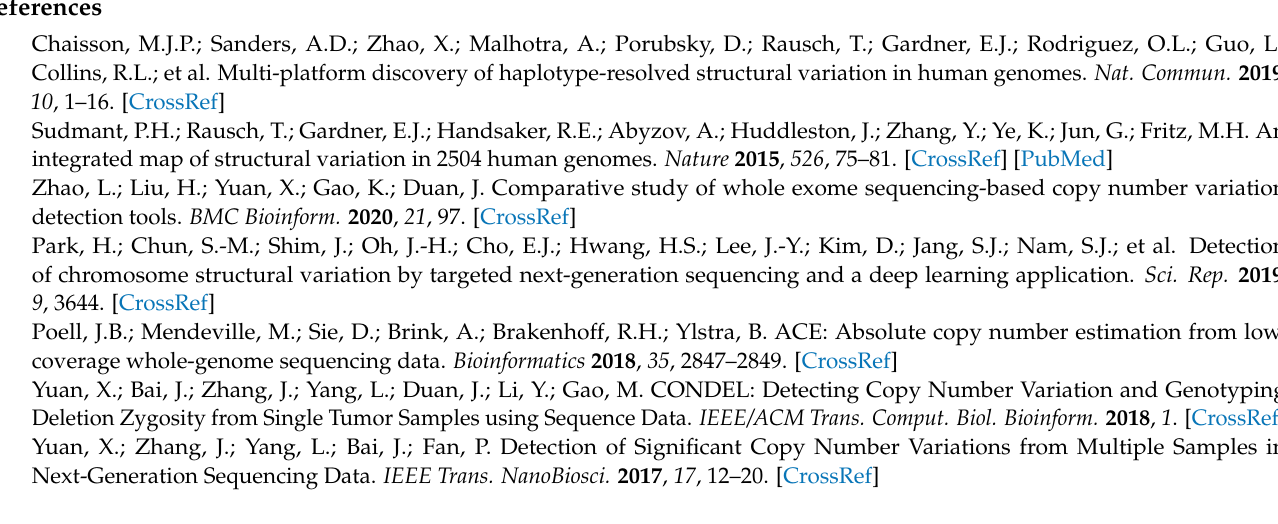
Table S3: The comparison of running time and memory usage between CIRCNV and CNV-LOF under the simulation configuration of tumor purity of 0.3 and coverage depth of 4 × . Table S4: The comparison of running time and memory usage between CIRCNV and CNV-LOF under the simulation configuration of tumor purity of 0.3 and coverage depth of 6 × . Table S5: The comparison of precision and sensitivity between CIRCNV and CNV-LOF when running on sequencing data with tumor purity of 0.8 and coverage depth of 1 ×